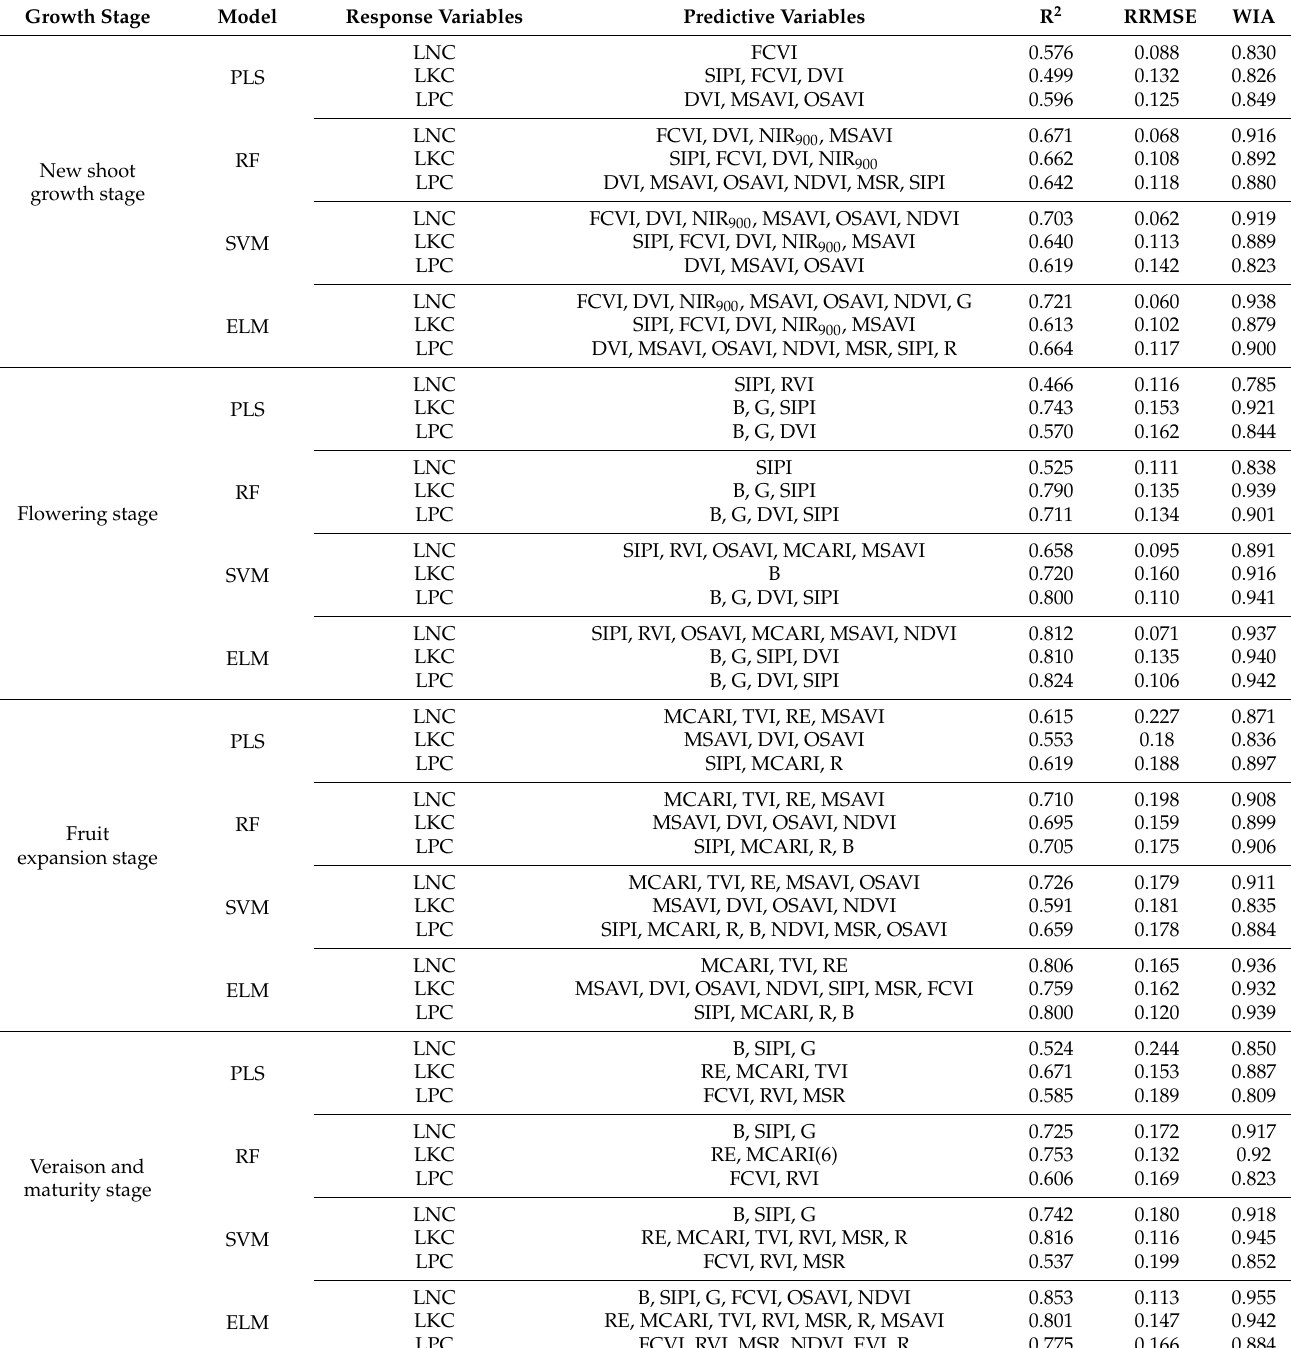
Table 7. Statistical analysis of prediction models constructed based on the number of the best